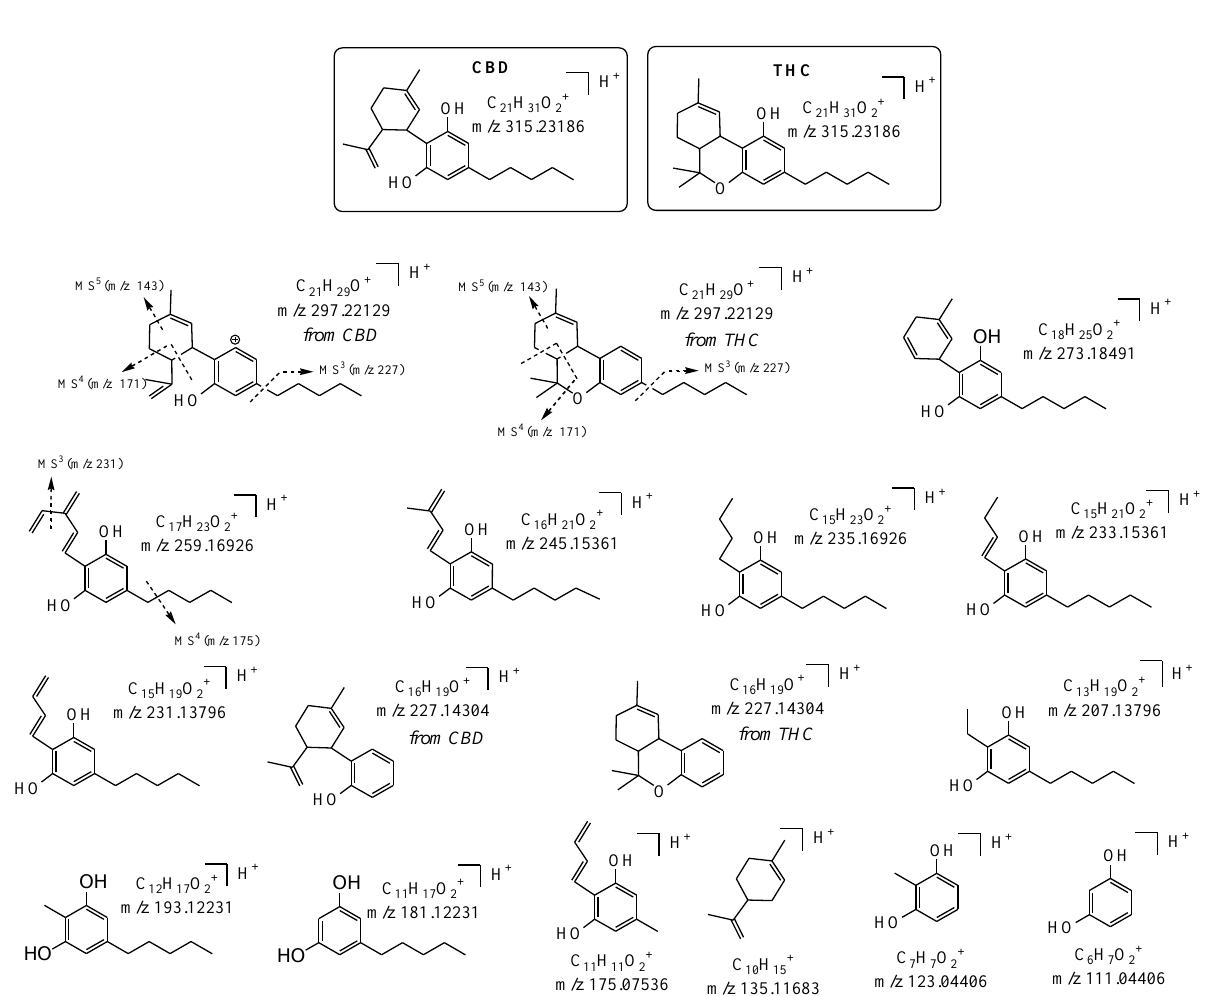
Figure 3. Proposed fragmentation structures for product ions of CBD and THC, based on IRMPD-MS/MS spectra and CID-MS n .